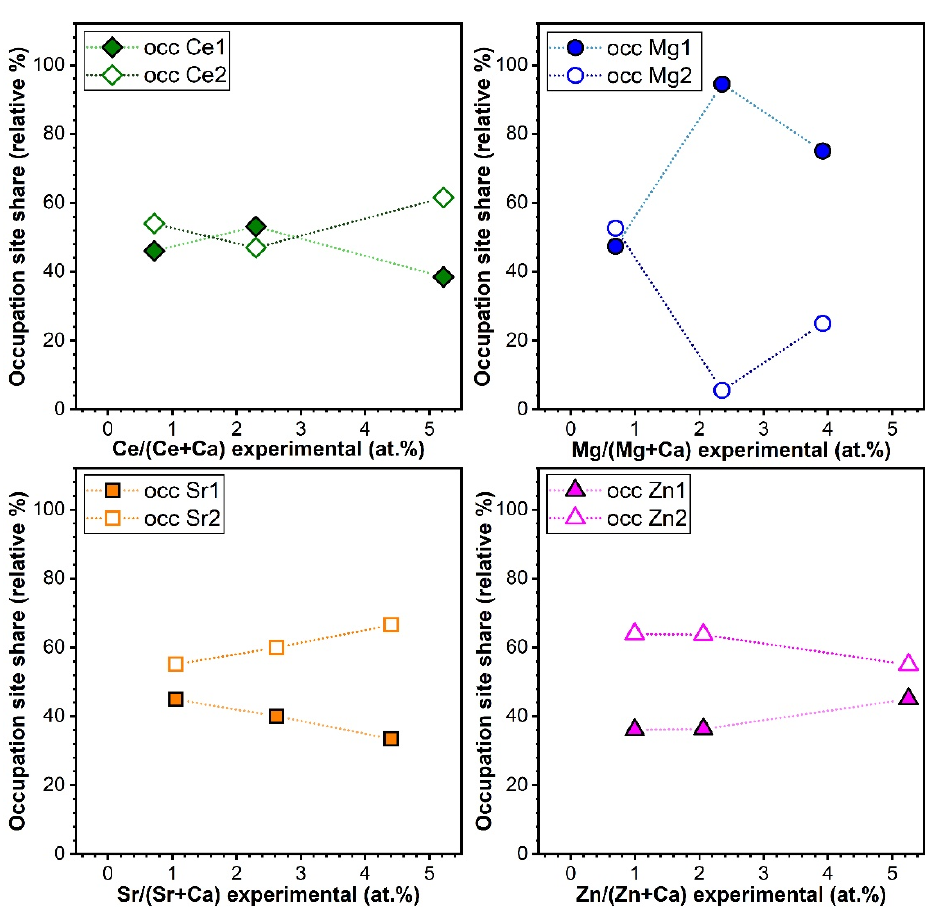
Figure 8. Cation occupation either on Ca(I) (occ Me 1) or Ca(II) (occ Me 2) sites as a function of the substituted cation concentration incorporated into the HA lattice.